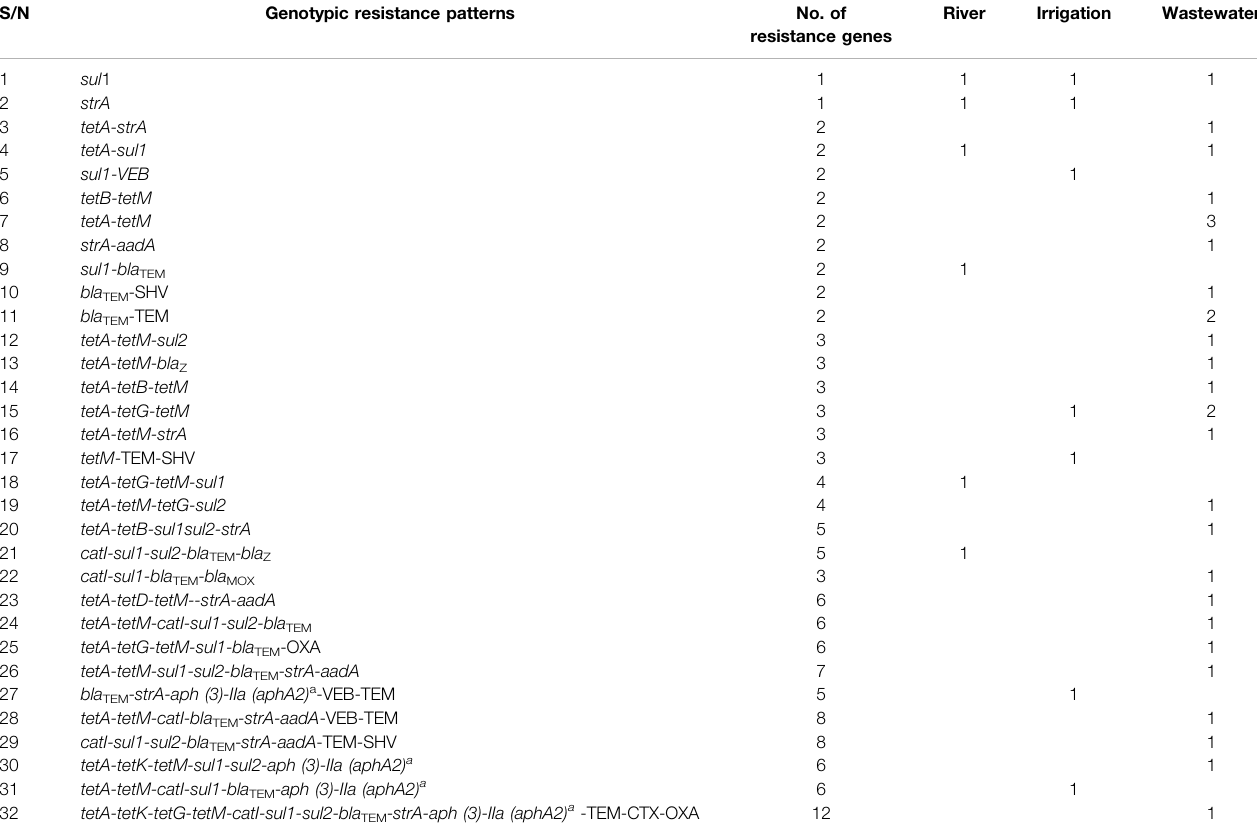
TABLE 5 | Genotypic resistance patterns of Listeria monocytogenes isolates recovered from water. S/N Genotypic resistance patterns